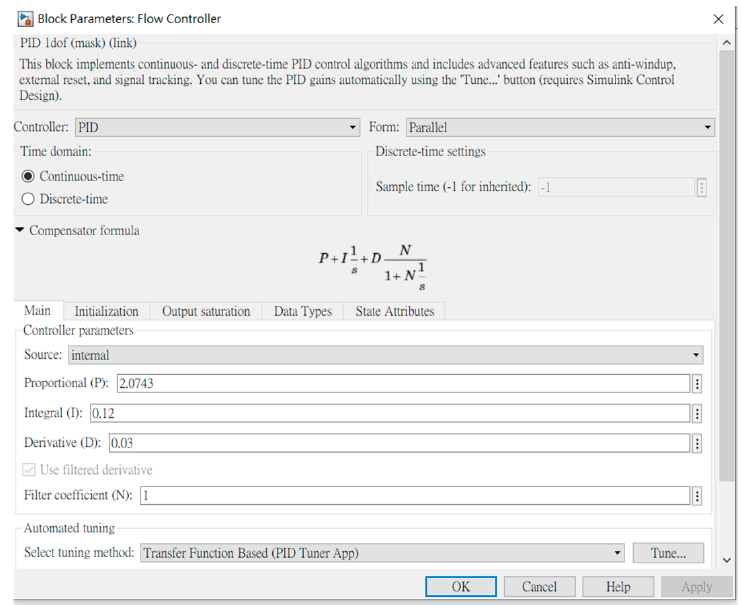
Figure 14. Diagram of proportional-integral-derivative (PID) gain parameters setting.